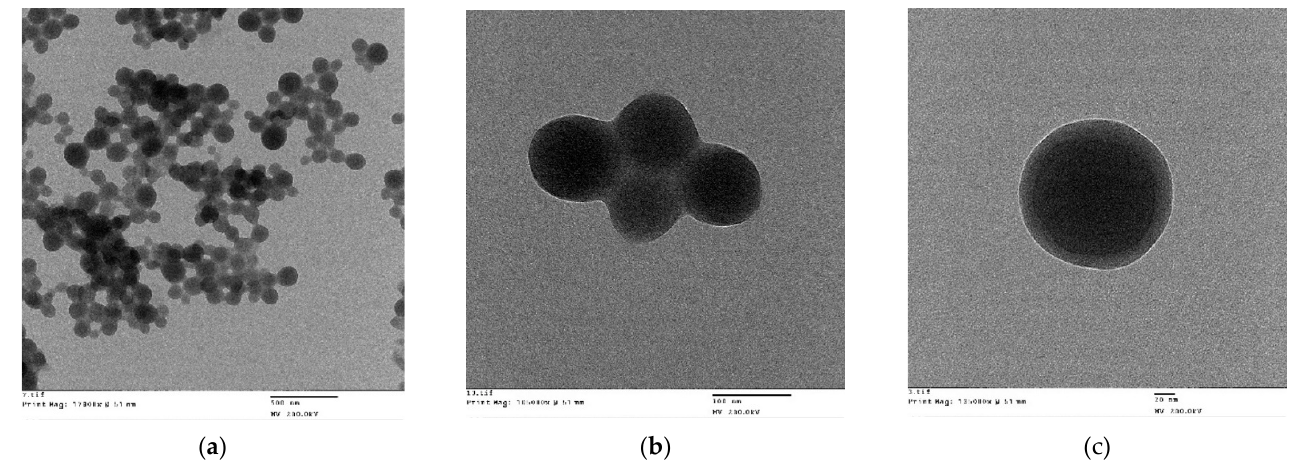
Figure 4. Nanoparticle surface characterization using TEM analysis: ( a ) Under magnification of 17800 ×, AT1-HSA-MRN-NPs of size 190.2 ± 5.7 nm with a zeta potential of − 29.5 ± 3.7 mV (Scale = 500 nm); ( b ) Under magnification of 105000 ×, AT1-HSA-MRN-NPs with moderately uniform particle size (Scale = 100 nm); ( c ) Under 135000 × magnification, the AT1-HSA-MRN-NPs display a dark core surrounded by a bright distinct membrane layer (Scale = 20 nm).